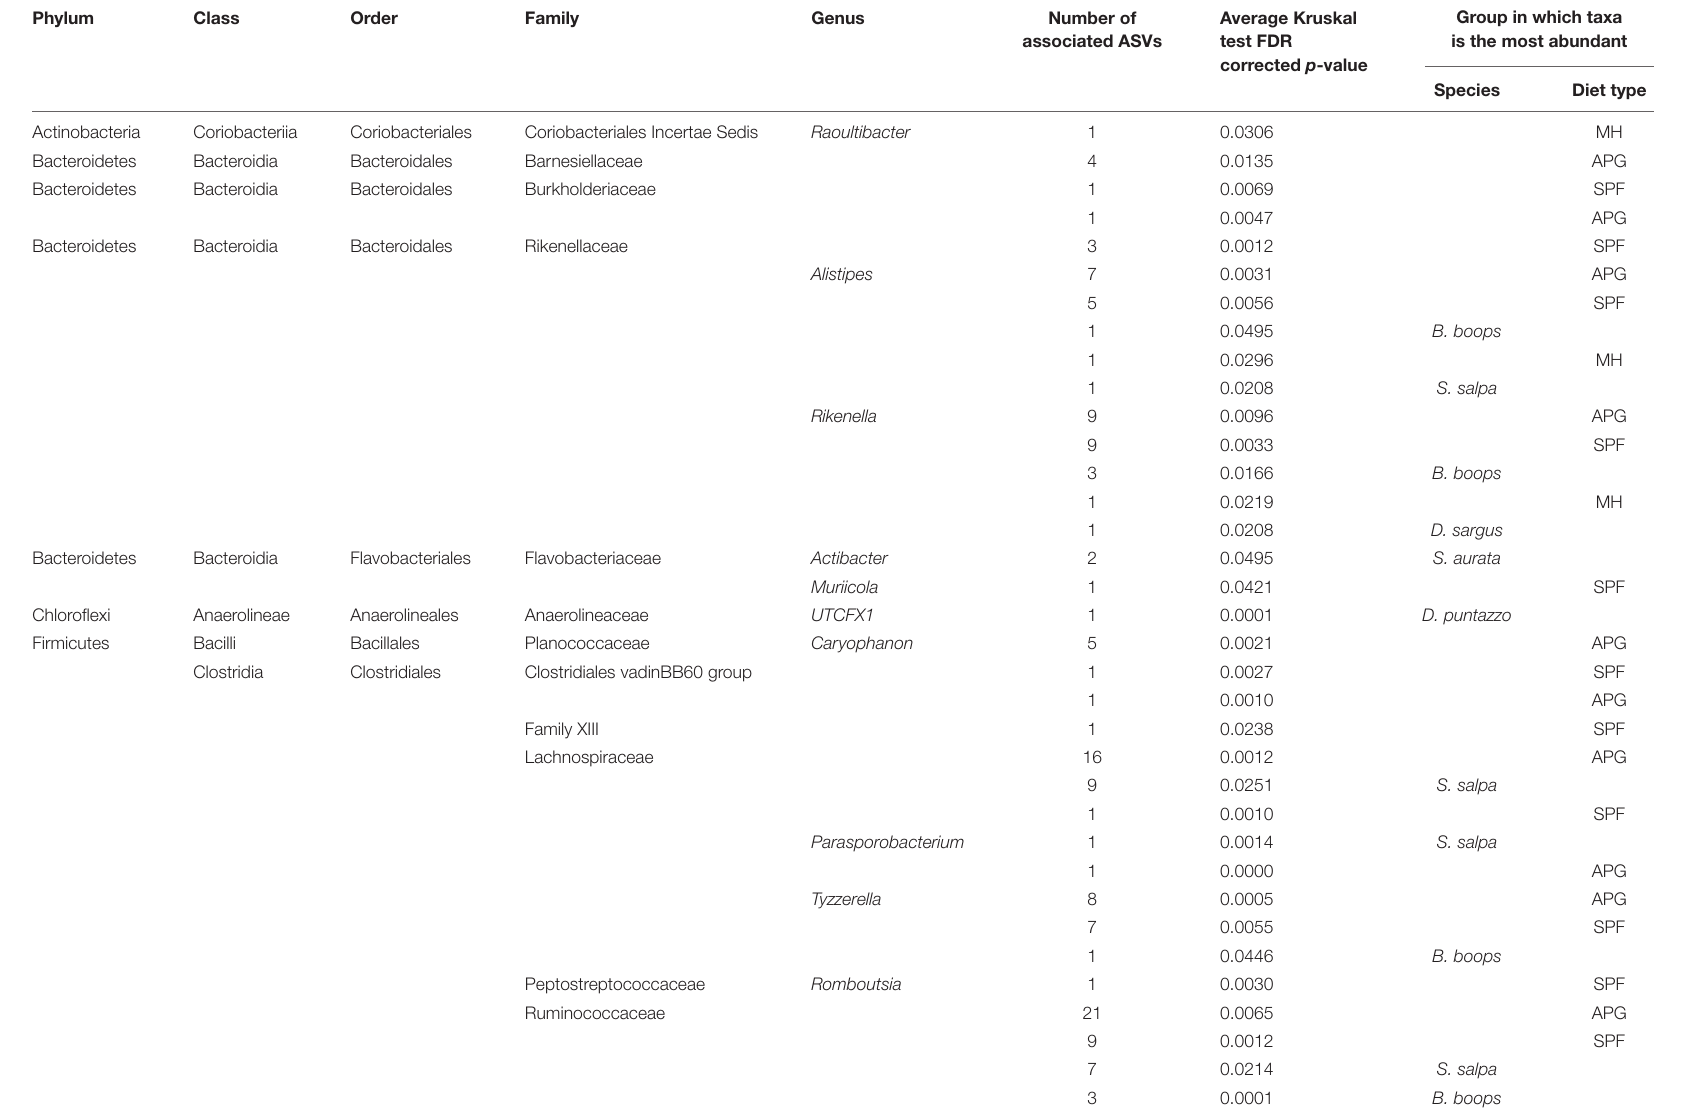
TABLE 2 | Bacterial taxa associated with Sparidae species and diet